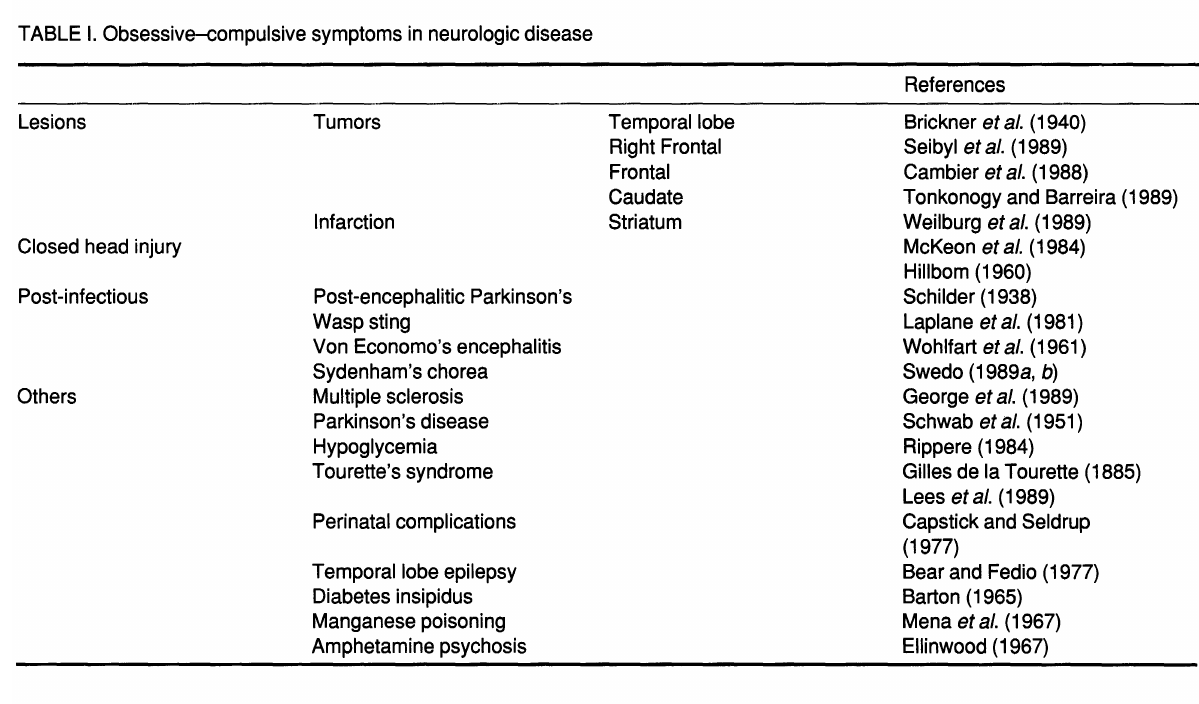
TABLE I. Obsessive--compulsive symptoms in neurologic